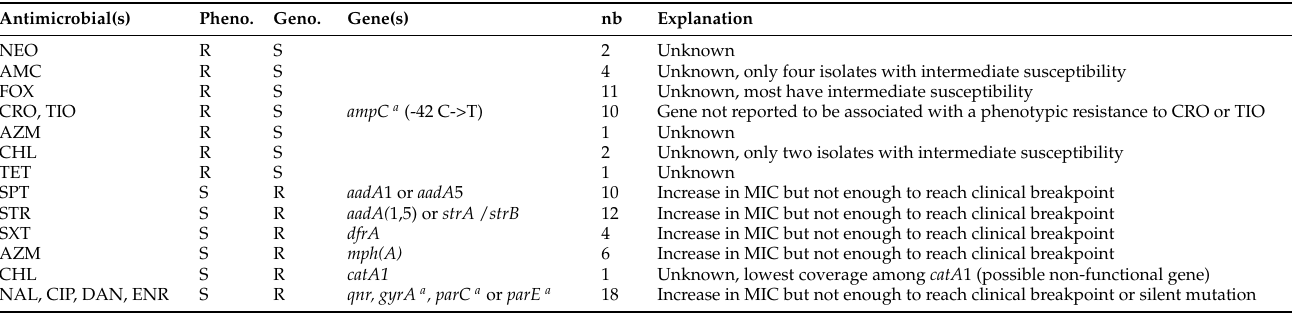
Table 4. List of discordance observed between antimicrobial resistance phenotypes and genotypes. Antimicrobial(s) Pheno.